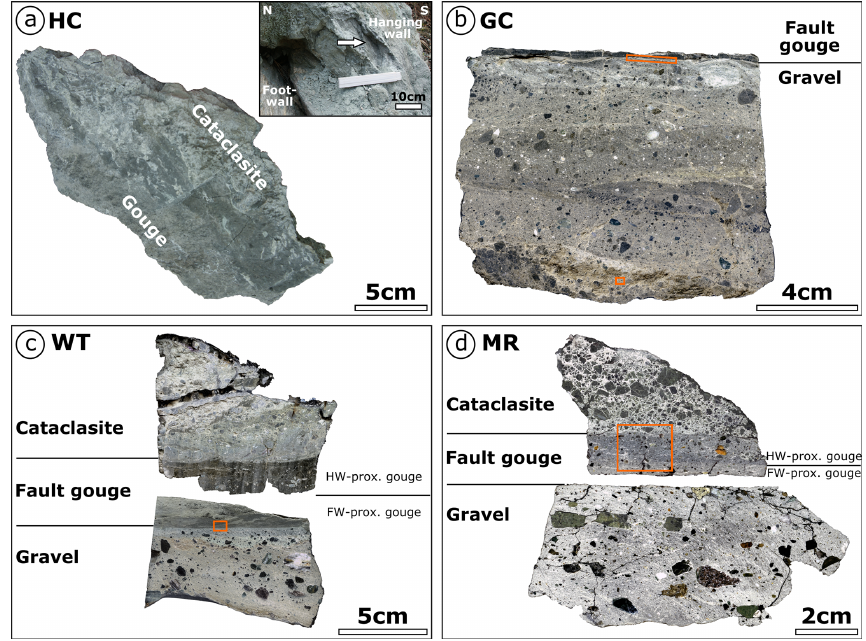
Figure 5. Investigated outcrop samples. (a) The contact between hanging wall cataclasites and thick fault gouge at Havelock Creek is poorly developed and appears to be transitional over ∼ 8cm. The inset provides a close-up of the sample location (indicated by the arrow). (b) Identifying the fault gouge in the field at the location Gaunt Creek turned out to be difficult. Consequently, only the lowermost part of the PSZ has been sampled. Contact between the PSZ and footwall is sharp. The orange box at the contact indicates location of Fig. 7k–m; the orange box at the bottom indicates location of Fig. 6d. (c) The thin fault gouge at Waikukupa Thrust consists of a hanging wall-proximal and footwall-proximal layer. The orange box gives location of Fig. 7j. (d) The contacts of the thin PSZ with hanging wall and footwall rocks, respectively, are sharp at Martyr River. Fault gouge consists of a hanging wall-proximal and a footwall-proximal layer. The orange box gives location of Fig. 7a and b. HC: Havelock Creek; GC: Gaunt Creek; WT: Waikukupa Thrust; MR: Martyr